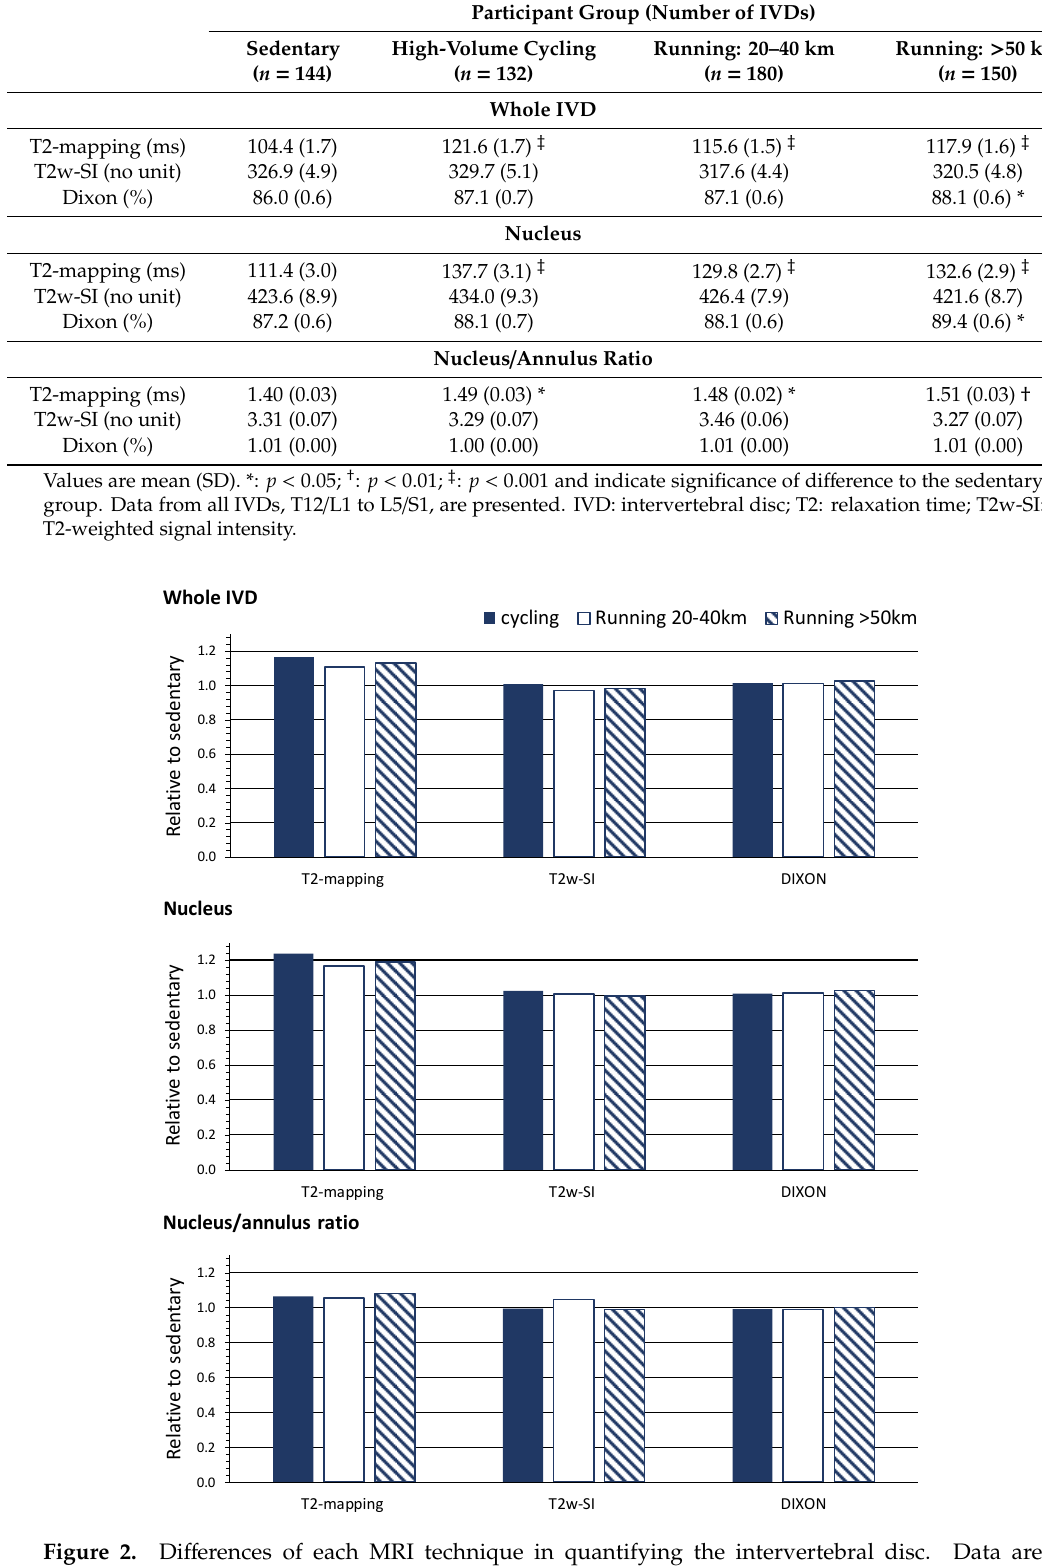
Table 1. Di ff erences between T2-mapping, T2w imaging and Dixon imaging according to physical activity histories.